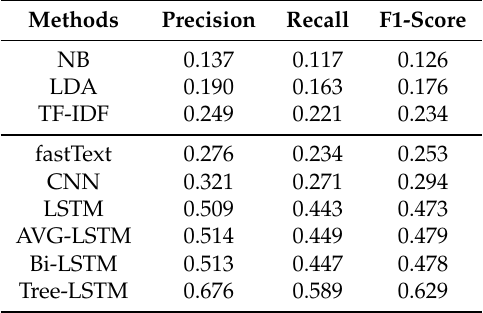
Table 3. Evaluation results of different methods for top-1 hashtag recommendation in Twitter